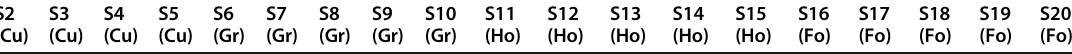
Table 4 Bray-Curtis ’ similarities between the 20 sampled sites of soil invertebrate macro-fauna at Shenkolla watershed, south central